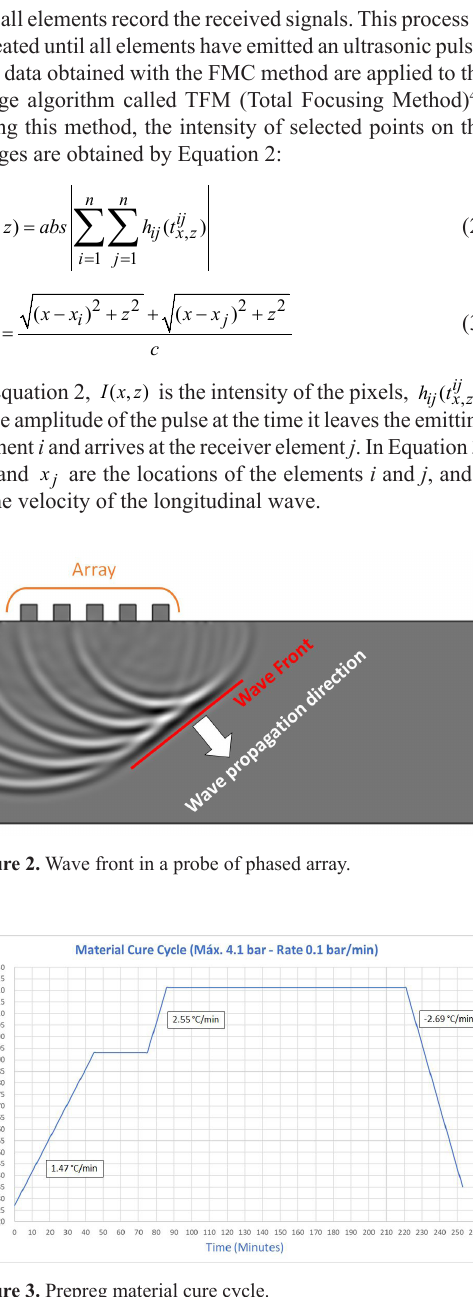
Figure 3. Prepreg material cure cycle.